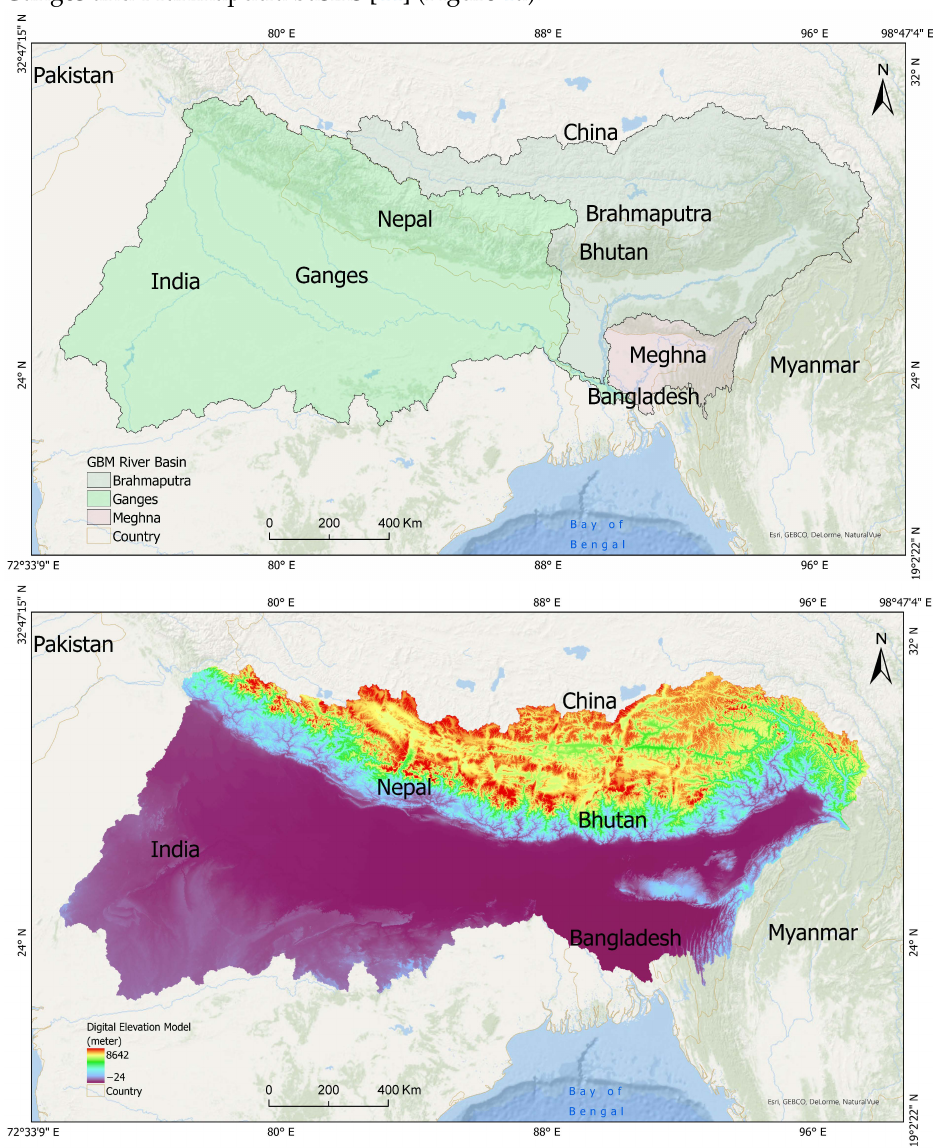
Figure 1. ( a ) Study area map of the GBM river basin; ( b ) Digital Elevation Model of the GBM river